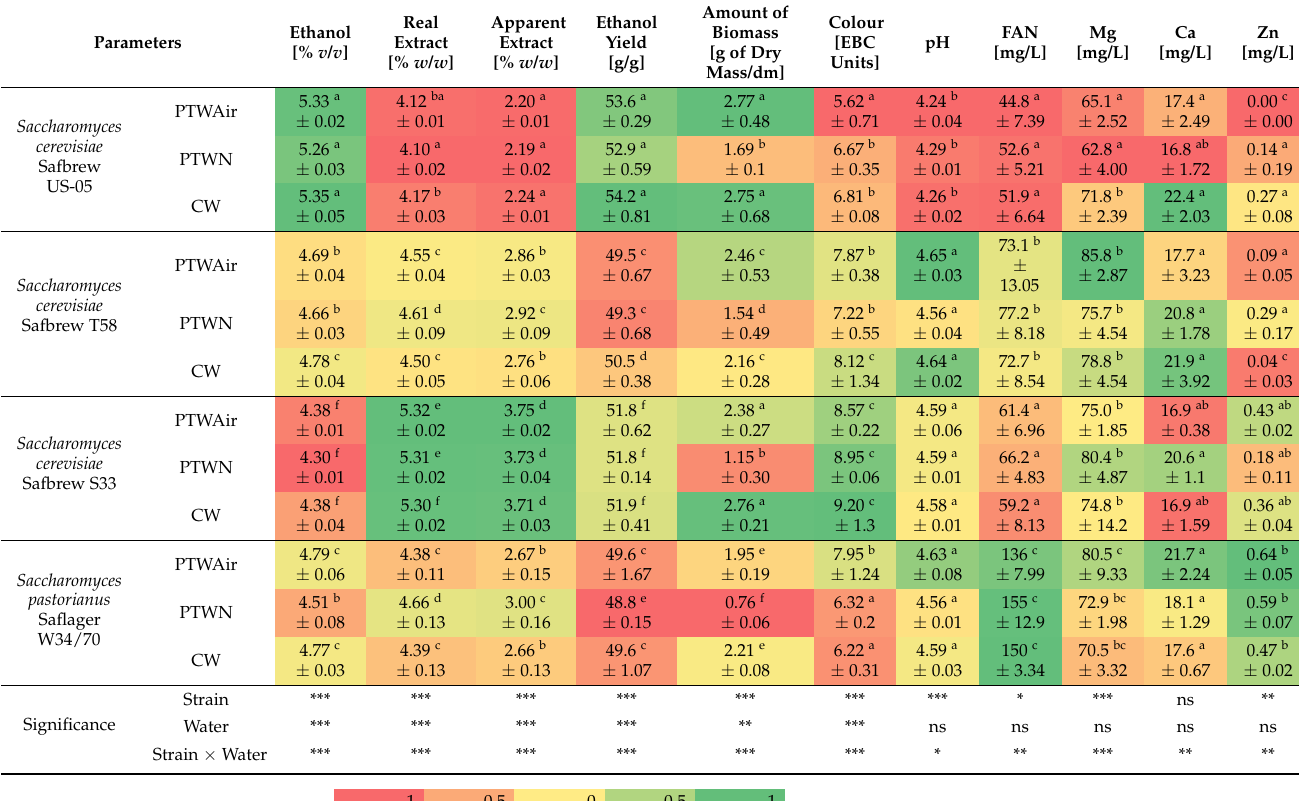
Table 2. Quality parameters in beers fermented by Saccharomyces cerevisiae (T58, US-05, S33) and Saccharomyces pastorianus (W34/70) after rehydration with PTWAir, PTWN and control water